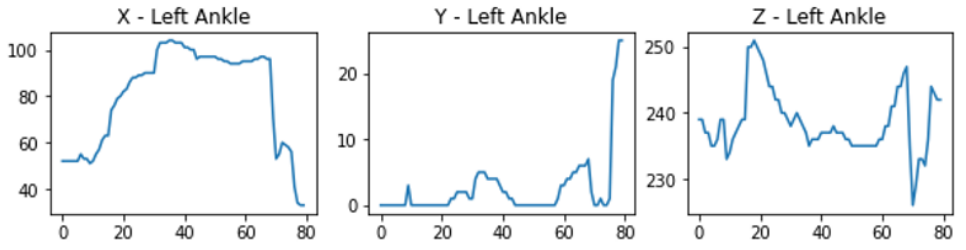
Figure 6. Raw data from left ankle joint.